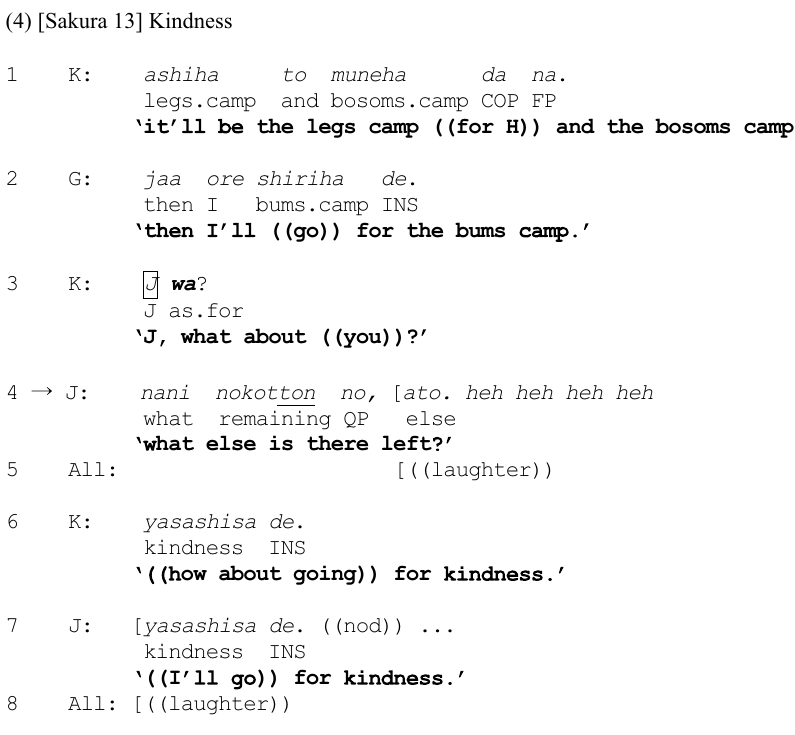
FIGURE 2 | Excerpt (2): In enquiring about the husband’s specialty, Mai marks “the husband” with wa , which has a tilting toward exclusion from {doctors of internal medicine} and toward inclusion in {doctors of specialty Y }, where Y is unspecified (left). Ken responds by marking “the husband” with